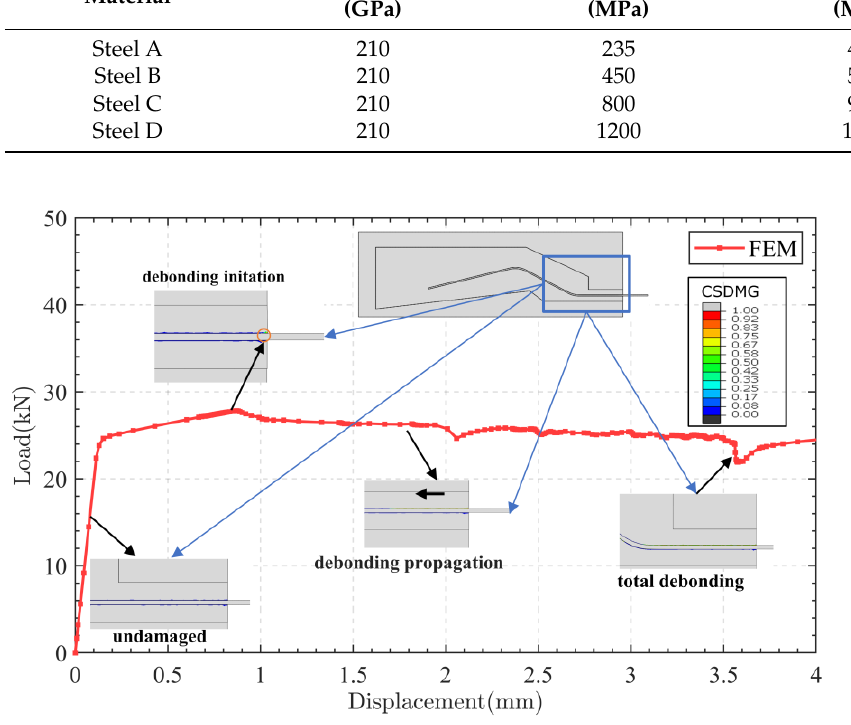
Figure 12. Failure process of the anchorage system .